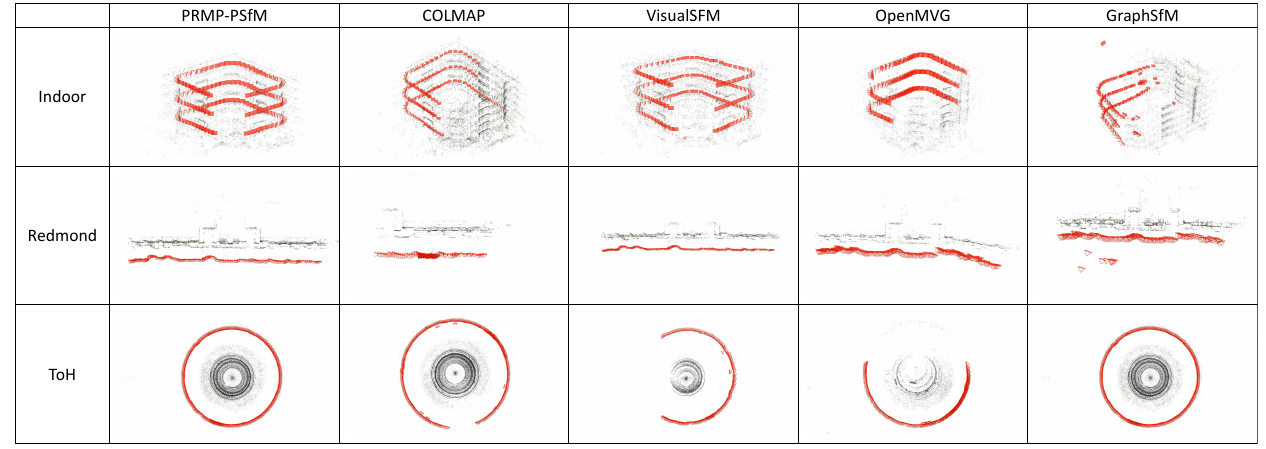
Figure 13. Reconstruction results on three middle-scale datasets with repetitive